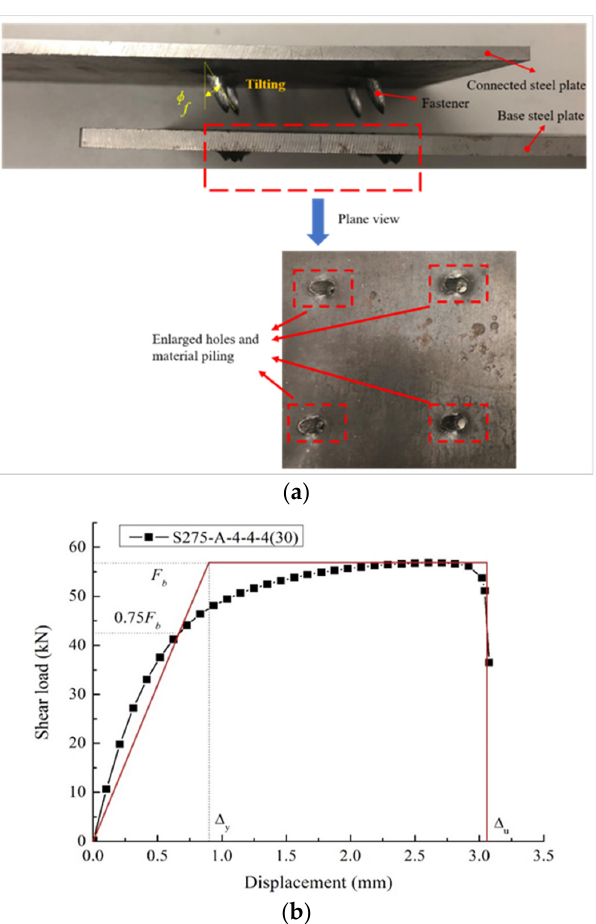
Figure 5. Mechanical behavior of connections: ( a ) bearing failure; ( b ) shear load versus displace- ment curve.